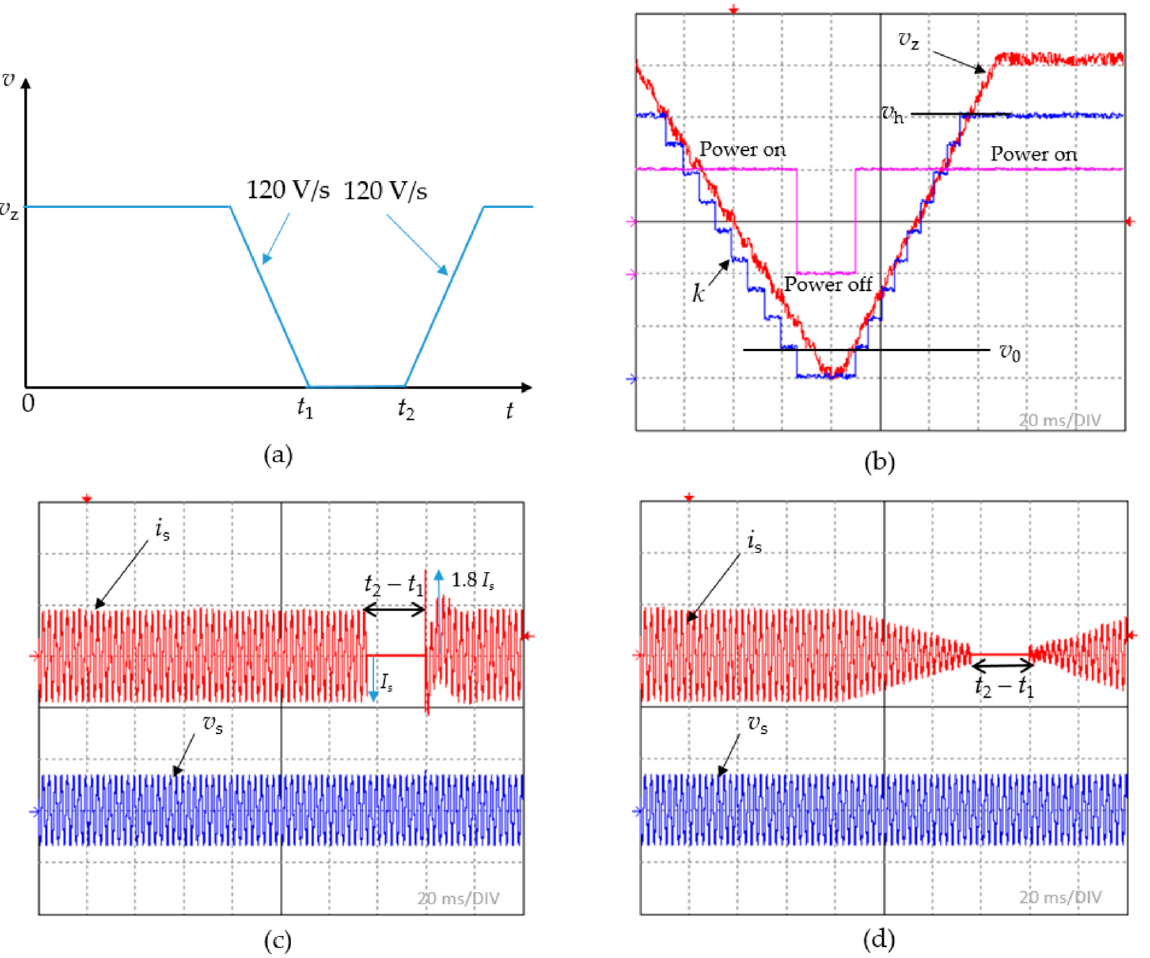
Figure 8. Dynamic response of the system to a voltage change on power bus 4: ( a ) assumed voltage profile on bus 4; ( b ) waveforms of the recorded voltage of bus 4 v z , correction factor k, and supply voltage identifier (pink color); waveforms of current i s and voltage vs. of bus 2 recorded in the classical system ( c ) and in the proposed system ( d ).